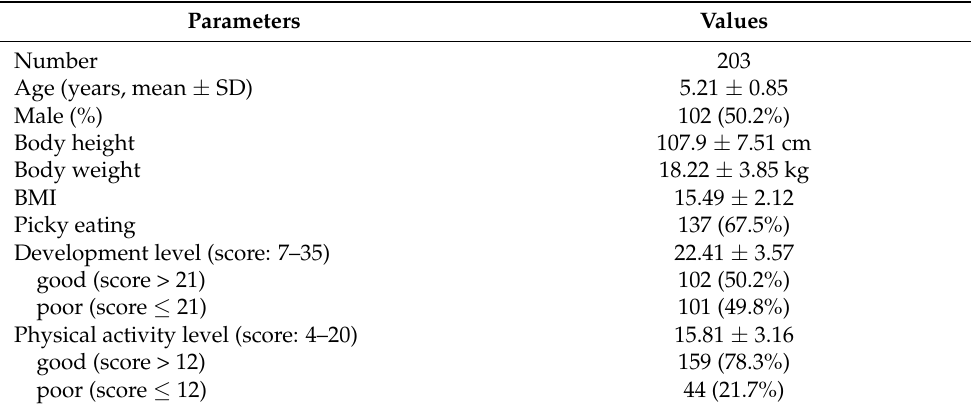
Table 1. Demographics and clinical characteristics of the subjects.